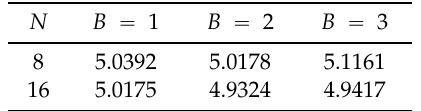
( b ) Figure 5. Graphical representation of the average results by using the PAQ8 scheme for the coding of the prediction errors. (cid:1840) = 8 ( a ) and (cid:1840) = 16 ( b ). Comparison with other Approaches In order to compare the experimental results achieved by our approach, we consider the Compression Ratio (C.R.) as a measure for the compression performances. In detail, Table 10 reports the results achieved by considering several parameters on all the hyperspectral images of the used dataset. More precisely, the results are reported in terms of C.R. and they are compared with other state of the art lossless compression schemes. From the experimental results, it should be observed that LMBHI gets its best results by using two previous bands as references ( i.e. when the following parameter is used: (cid:1828) = 2 ), LMBHI outperforms, in average, all the other state of the art approaches. On the other hand, when only the previous band is used ( i.e. , when (cid:1828) = 1 ), LMBHI outperforms all the compared state of the art techniques, with the exception of LPVQ. But, LPVQ is not suited for on board implementation.